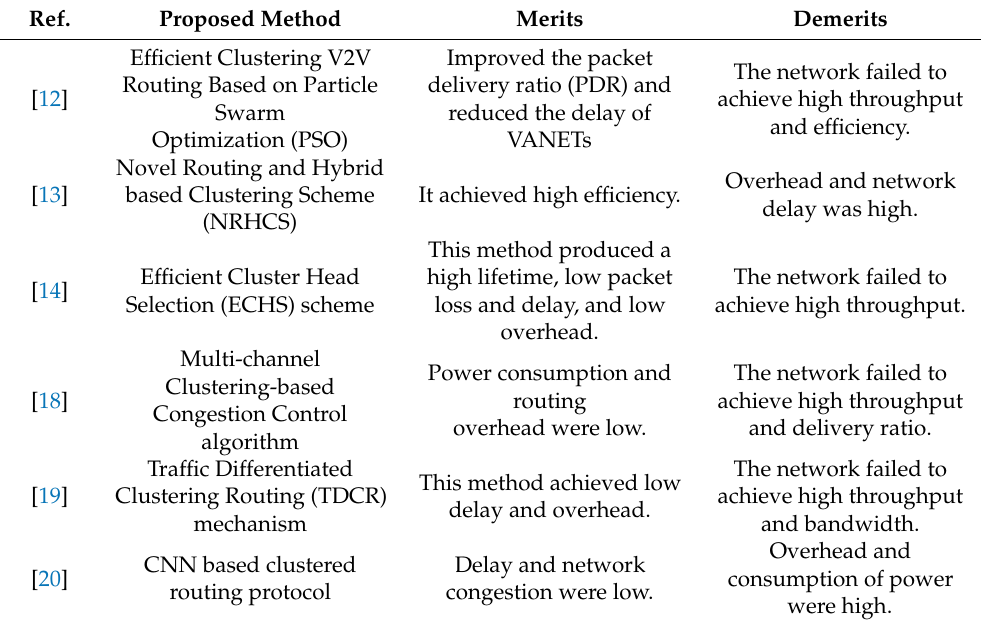
Table 1. Related